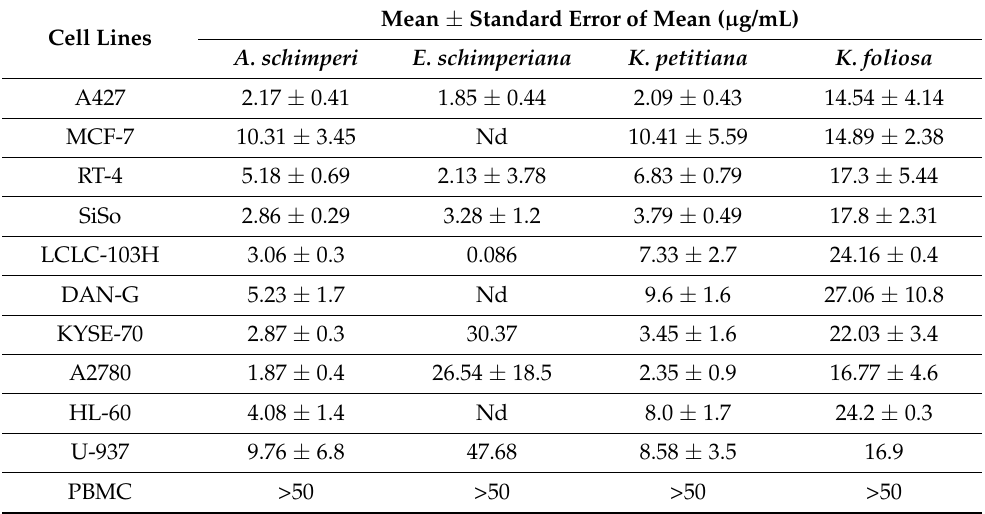
Table 2. IC 50 values ( µ g/mL) for the activities of crude extracts against 10 human cancer